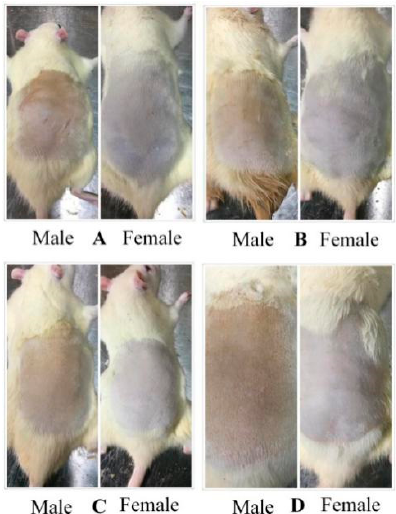
Figure 3. The skin condition of rats after administration VD 3 solution, VD 3 liposomes or aloe-gel for one month. ( A ) Treatment with PBS as a control group. ( B ) Treatment with VD 3 solution. ( C ) Treatment with VD 3 liposomes. ( D ) Treatment with aloe-gel as a positive control group.